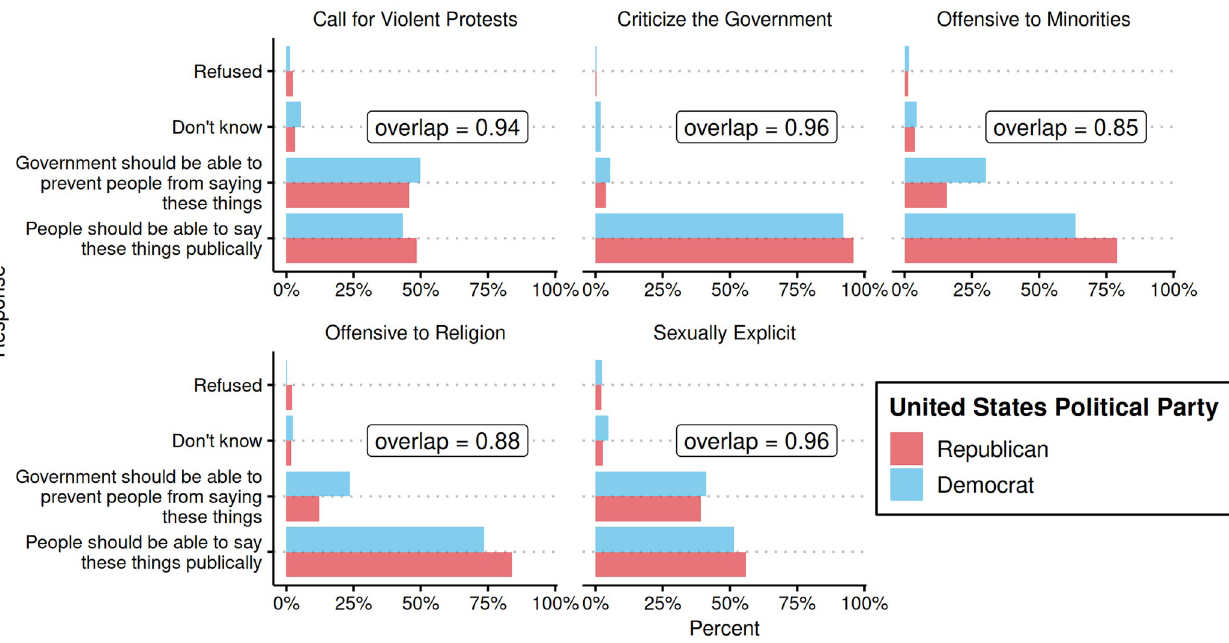
PLOS ONE | https://doi.org/10.1371/journal.pone.0231794 April 23,